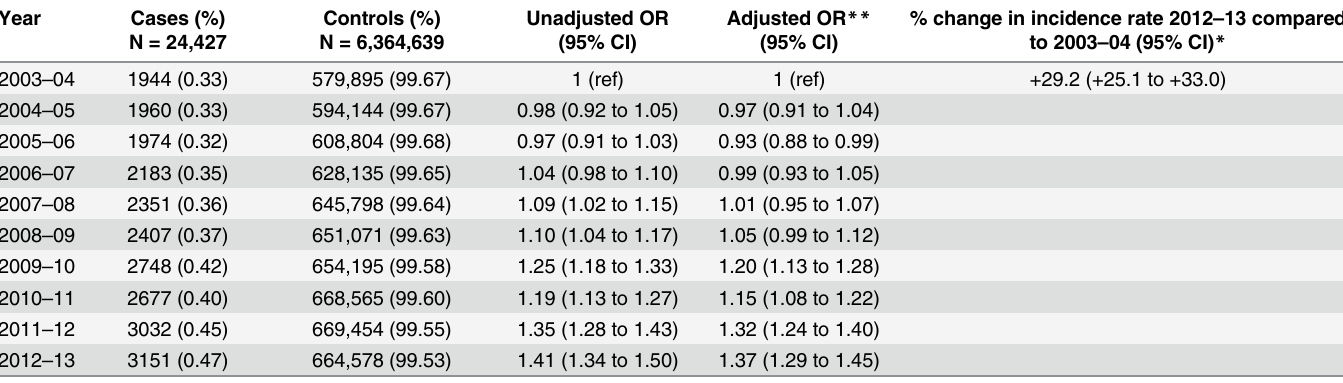
Table 2. Maternal morbidity outcomes during childbirth in England from 2003 to 2013; Hospital Episode Statistics data